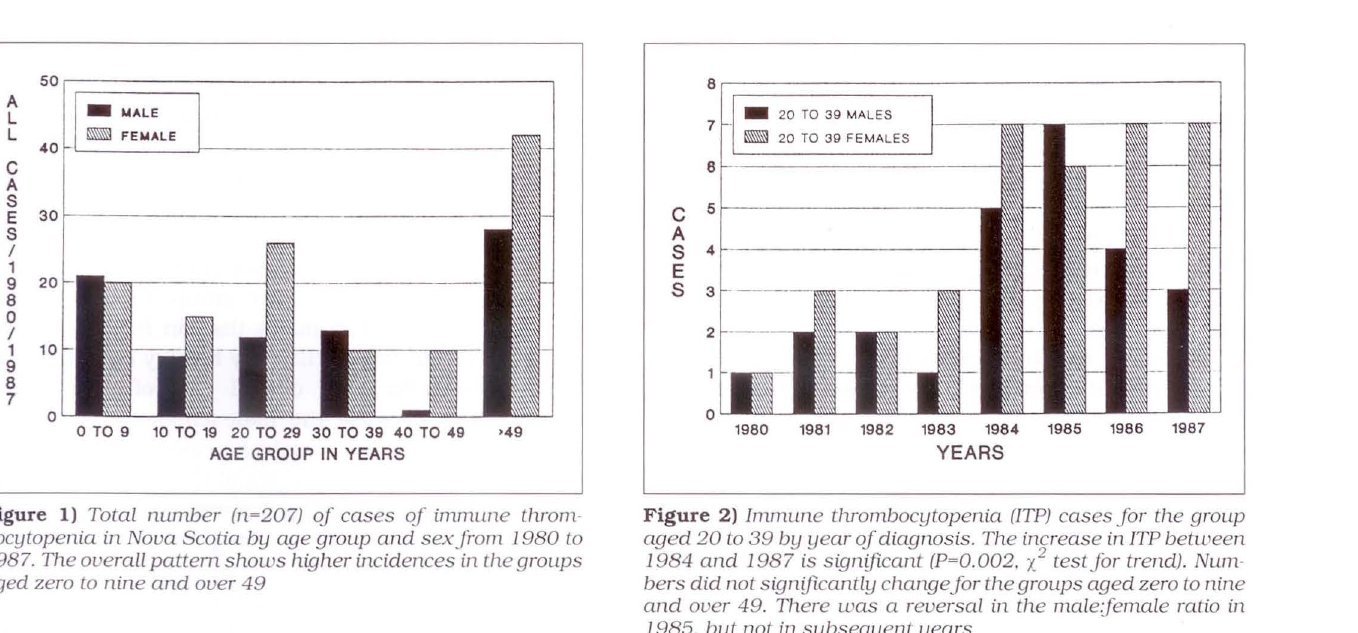
Figure 2) Immune thrombocytopenia (ITPJ cases for the group aged 20 to 39 by year of diagnosis. Tl1e increase in ITP between l 1984 and 1987 is significant (?=0.002. testfor trend). Num bers did not significantly change for the groups aged zero to nine and over 49. There was a reversal in the malejemale ratio in 1985. but not in sttbsequenl years